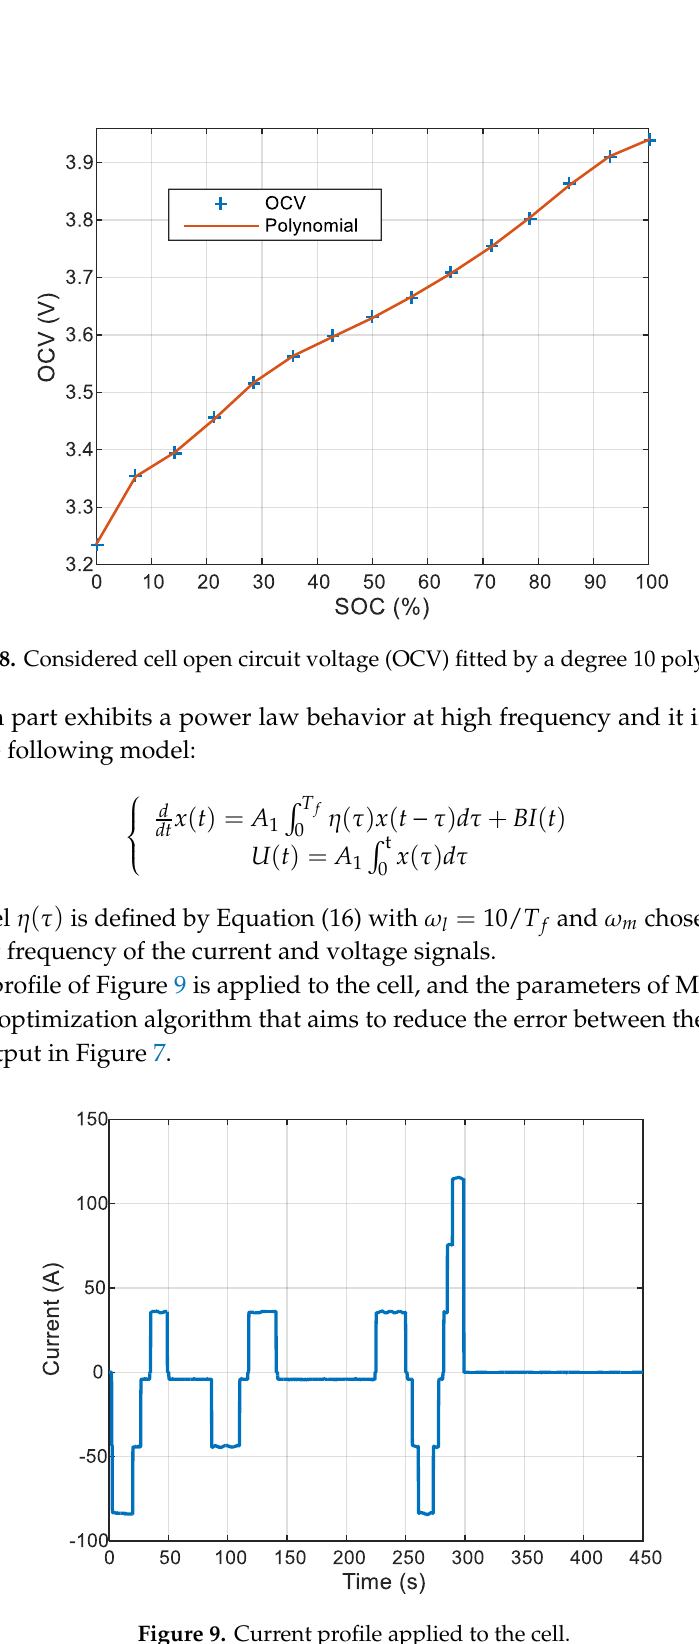
Figure 9. Current profile applied to the cell.